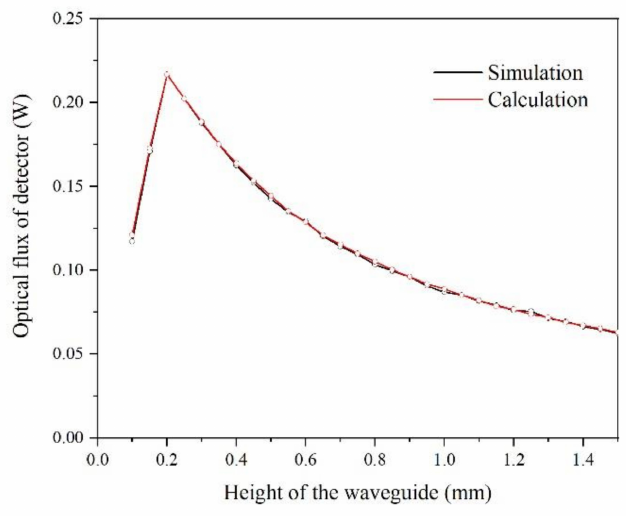
Figure 4. The function curve of optical flux with respect to the height of the